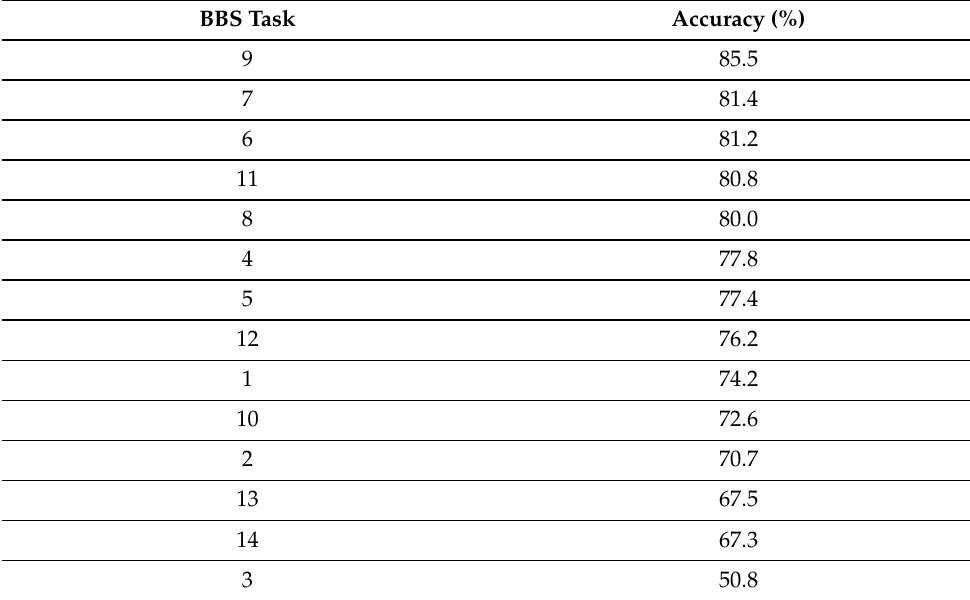
Table 3. Singe BBS tasks—predictor